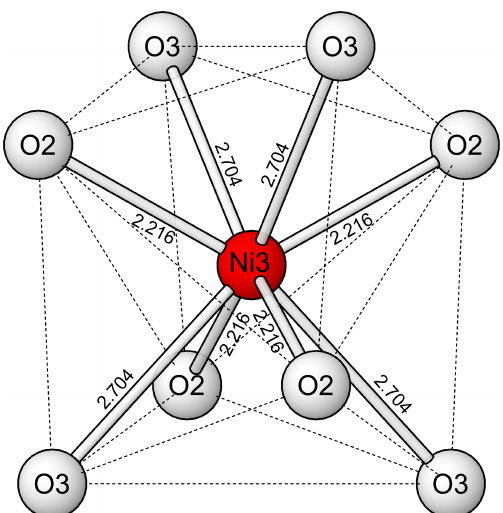
Figure 7. The dodecahedrally coordinated site in the structure of